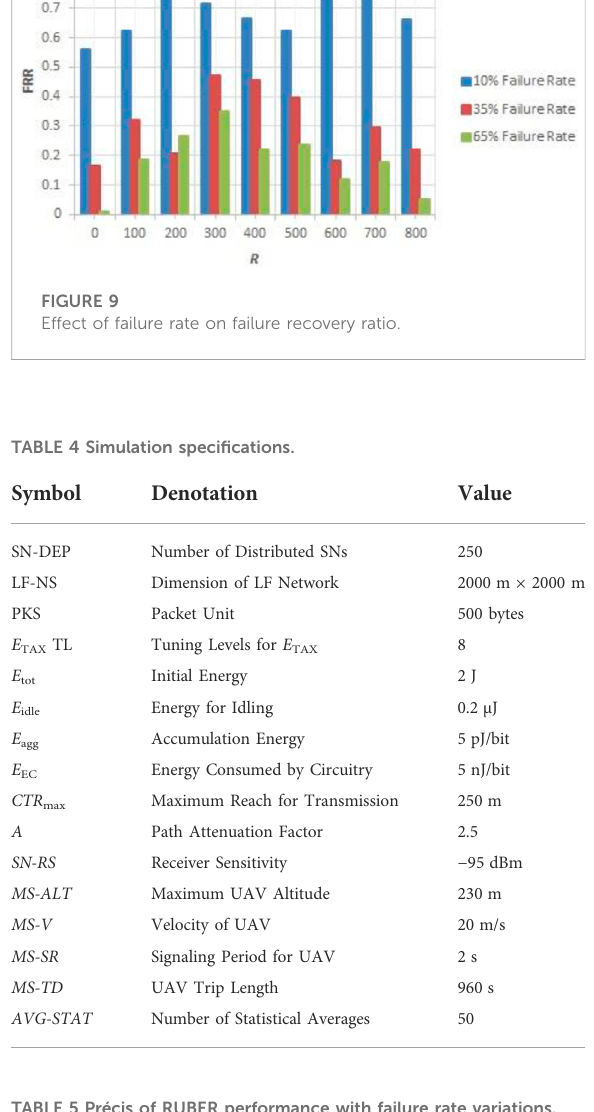
TABLE 5 Précis of RUBER performance with failure rate